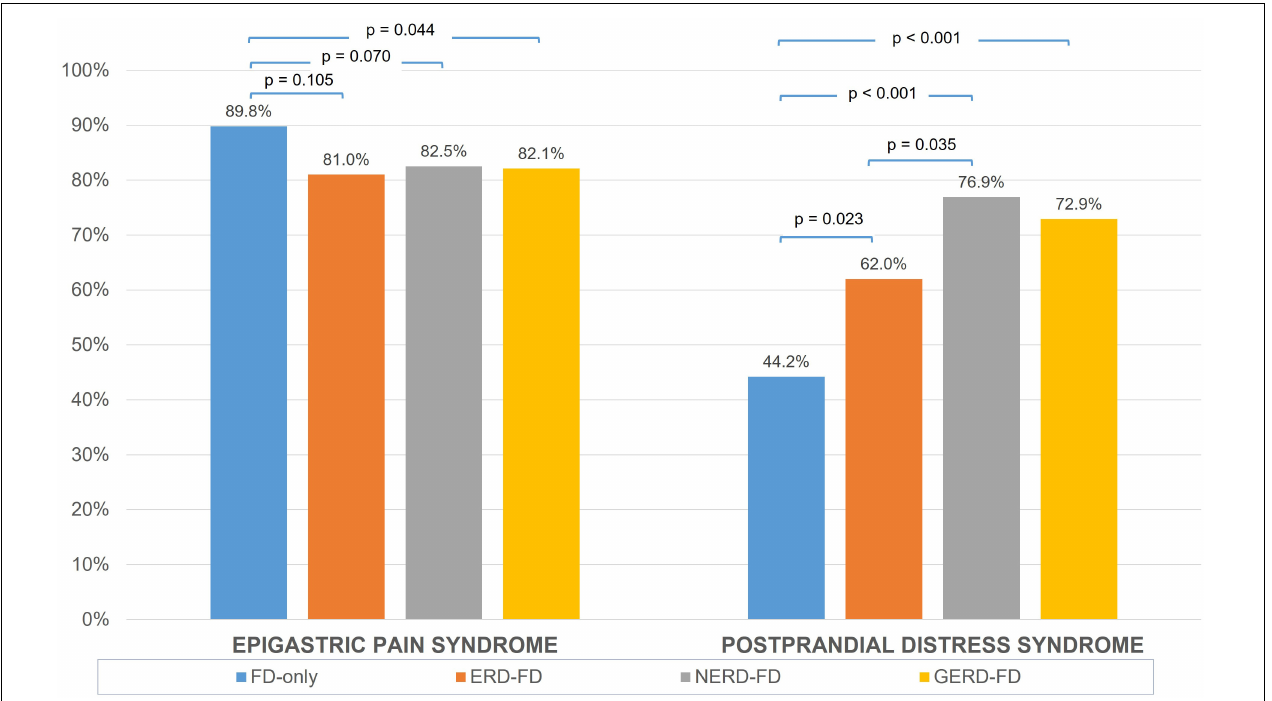
FIGURE 2 | The distribution of epigastric pain syndrome and postprandial distress syndrome across the FD-only and GERD-FD overlap groups. FD, functional dyspepsia; GERD, gastroesophageal reflux disease; ERD, erosive reflux disease; NERD, non-erosive reflux